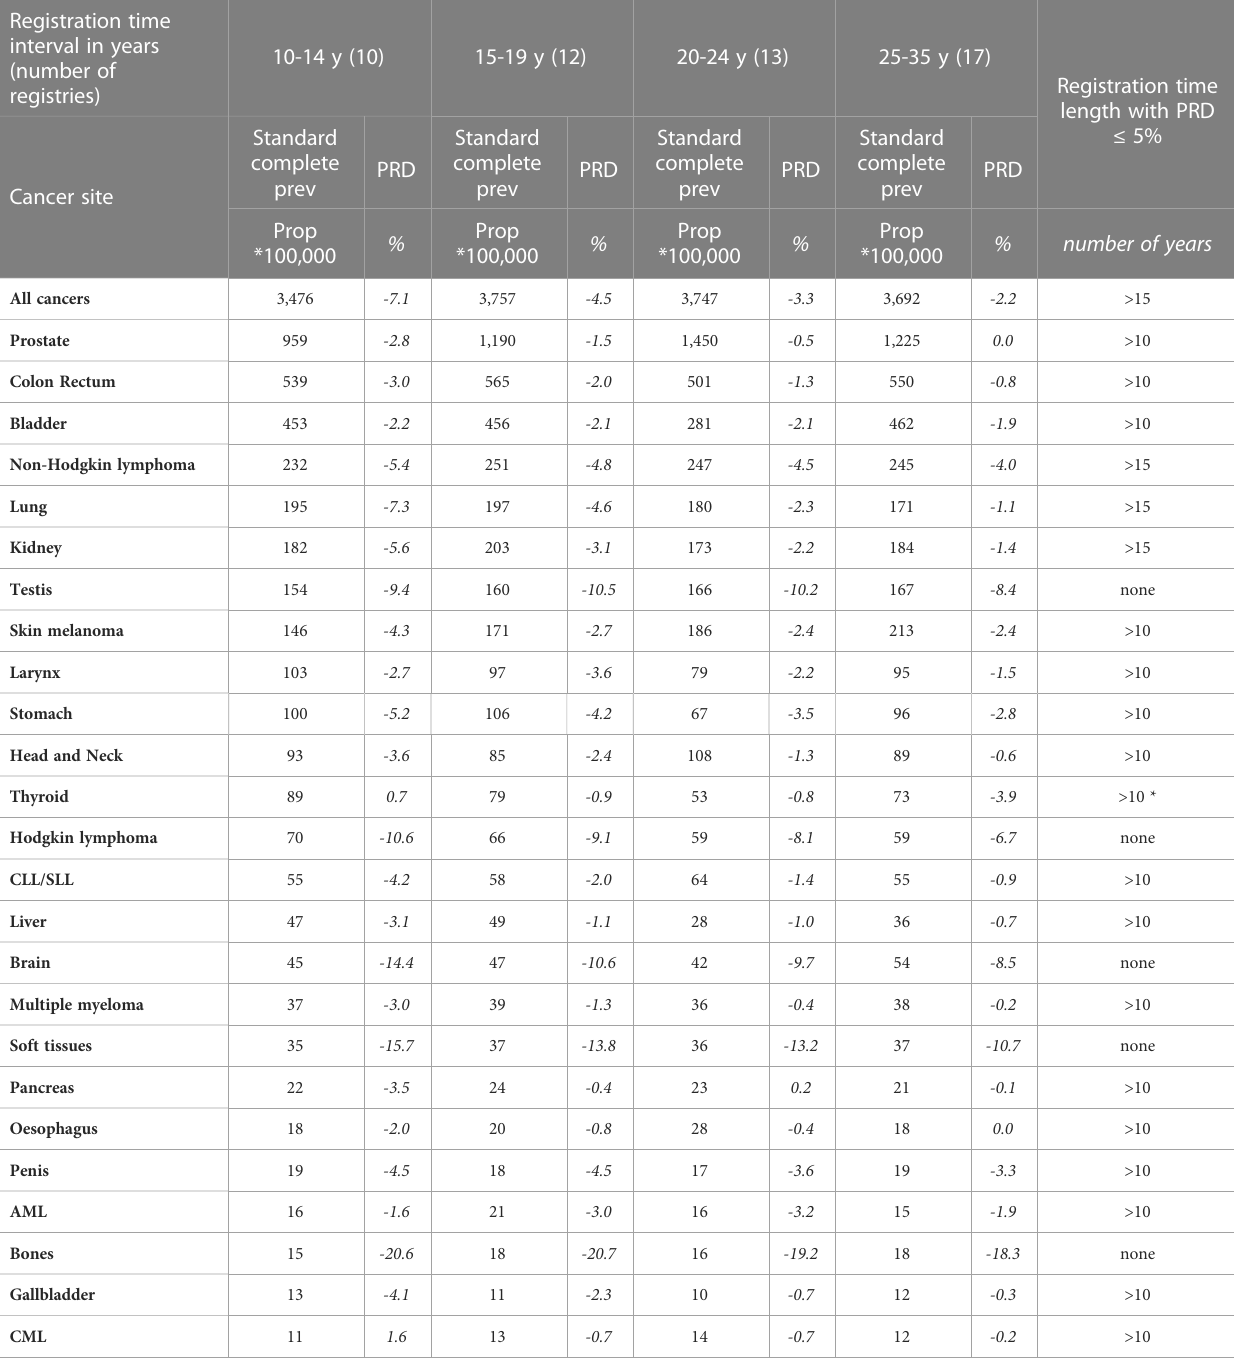
TABLE 3A Comparison between empirical and standard model-based complete prevalence at 1/1/2013 by cancer site for the 62 European registries included in the study grouped by registration time length (from 10-14 years to 25-35 years),